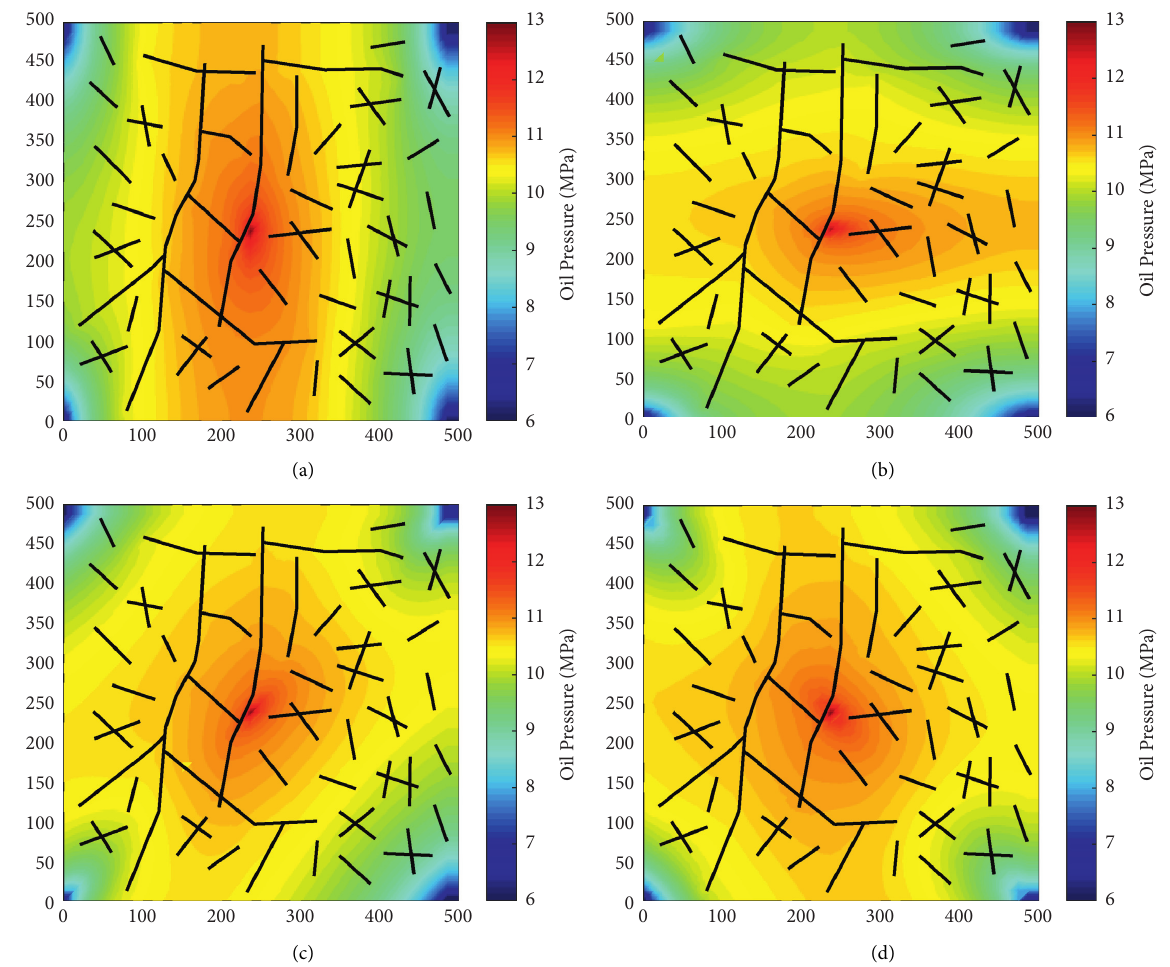
Figure 28: Oil pressure profiles for (a) Case 1, (b) Case 2, (c) Case 3, and (d) Case 4 after 10000